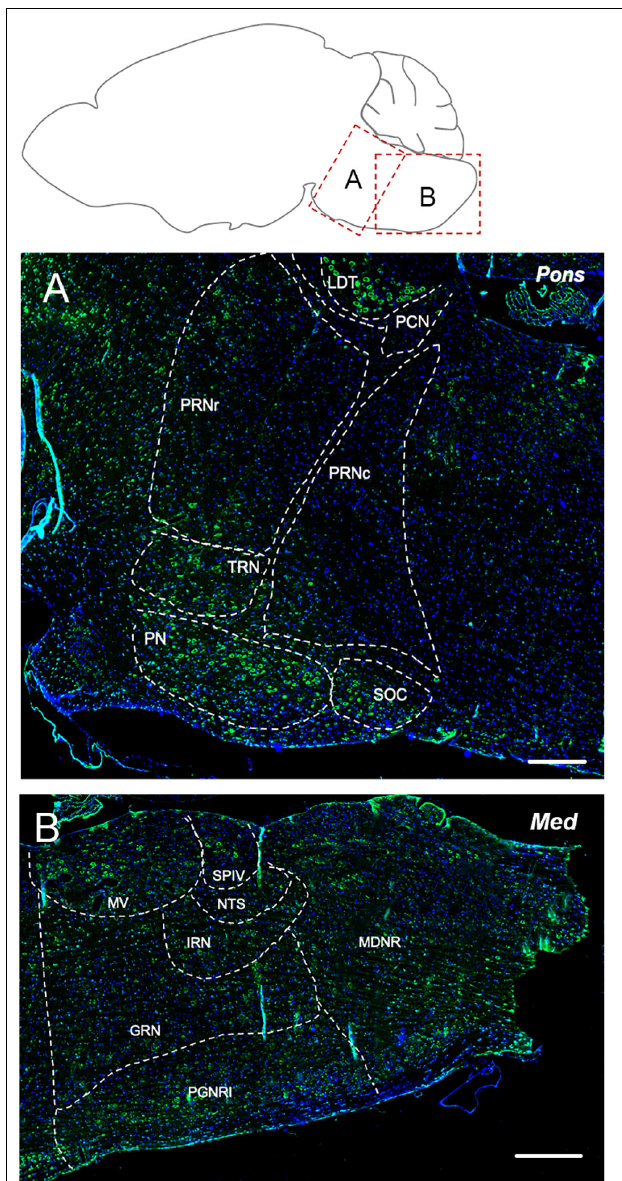
FIGURE 5 | Elovl5 expression in pons and medulla. (A) In the pons, the most prominent labeling for Elovl5 is shown by tegmental nuclei, while pontine nuclei, tegmental reticular nucleus and superior olivary complex displayed a moderately strong signal. Medium-low intensity is shown by pontine reticular nuclei. (B) In the medulla, very strong labeling for Elovl5 is shown by medial vestibular nucleus and spinal vestibular nucleus. A moderate to weak signal is detected in the nucleus of the solitary tract, intermediate reticular nucleus and gigantocellular reticular nucleus. A non-homogeneous pattern of expression is present in the paragigantocellular reticular nucleus and medullary reticular nucleus. (A) LDT, Laterodorsal Tegmentel Nucleus; PCN, Pontine Central Nuclei; PRNc, Pontine Reticular Nucleus, caudal part; PRNr, Pontine Reticular Nucleus, rostral part; TRN, Tegmental Reticular Nucleus; PN, Pontine Nuclei; SOC, Superior olivary Complex. (B) MV, Medial Vestibular Nucleus; SPIV, Spinal Vestibular Nucleus; NTS, Nucleus of Solitary Tract; IRN, Intermediate reticular Nucleus; GNR, Gigantocellular Reticular nucleus; PGNR, Paragigantocellular Reticular nucleus; MDRN, Medullary Reticular nucleus. Scale bars: (A) 200 µ m and (B) 250 µ m.